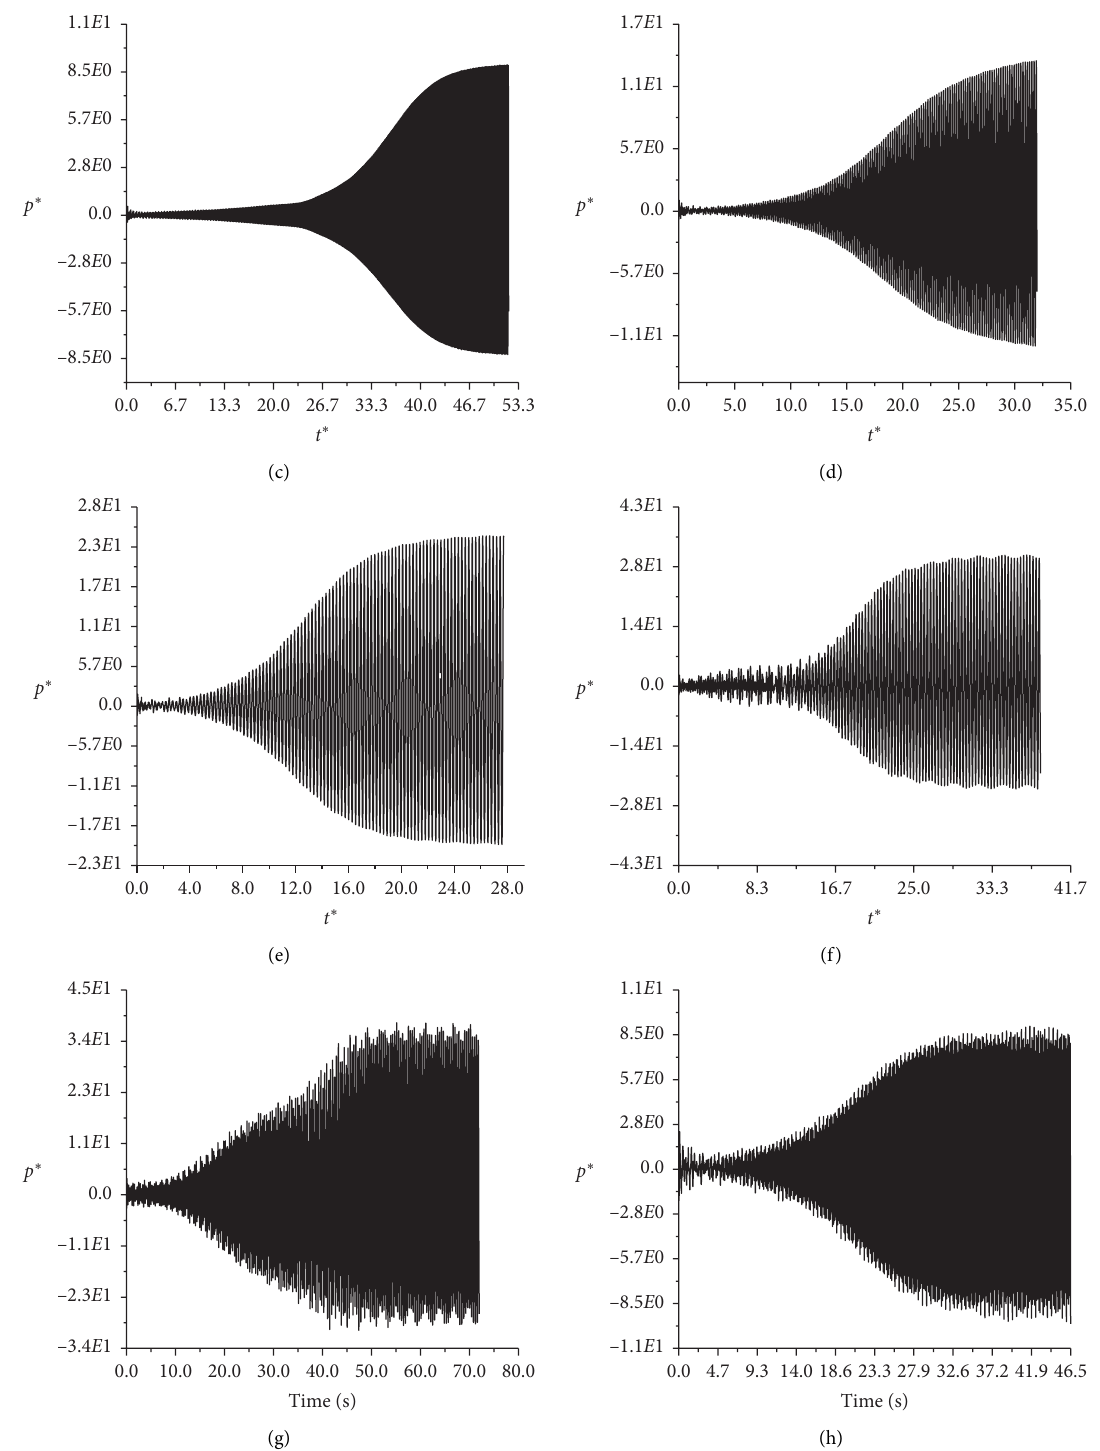
Figure 6: Pressure fluctuation: (a) v � 10m/s, (b) v � 15m/s, (c) v � 20m/s, (d) v � 30m/s, (e) v � 40m/s, (f) v � 50m/s, (g) v � 60m/s, and (h) v �